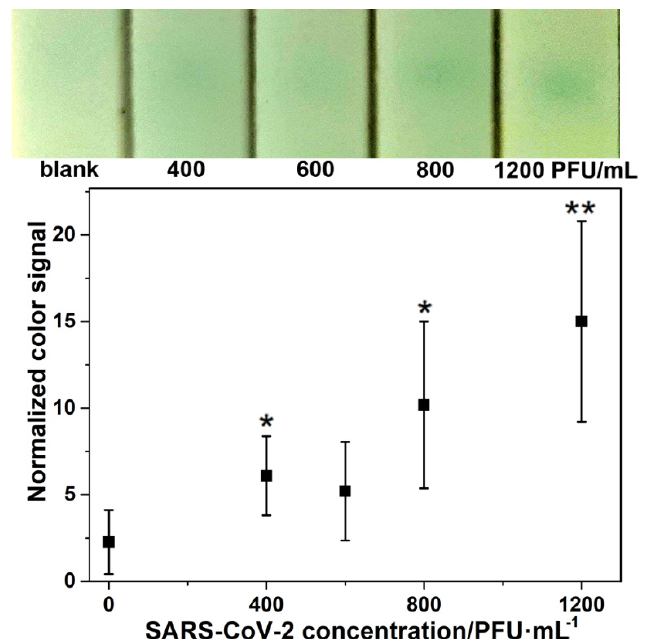
Figure 4. Detection results and the normalized colorimetric signal from blank (81.4 %RSD), 400 PFU/mL (37.5 %RSD, p -value 0.087 vs. blank marked as * in Figure 4), 600 PFU/mL (54.7 %RSD, p -value 0.21 vs. blank), 800 PFU/mL (47.4 %RSD, p -value 0.057 vs. blank marked as * in Figure 4), and 1200 PFU/mL (38.6 %RSD, p -value 0.022 vs. blank marked as ** in Figure 4) of SARS-CoV-2 in PBS buffer ( n = 3).